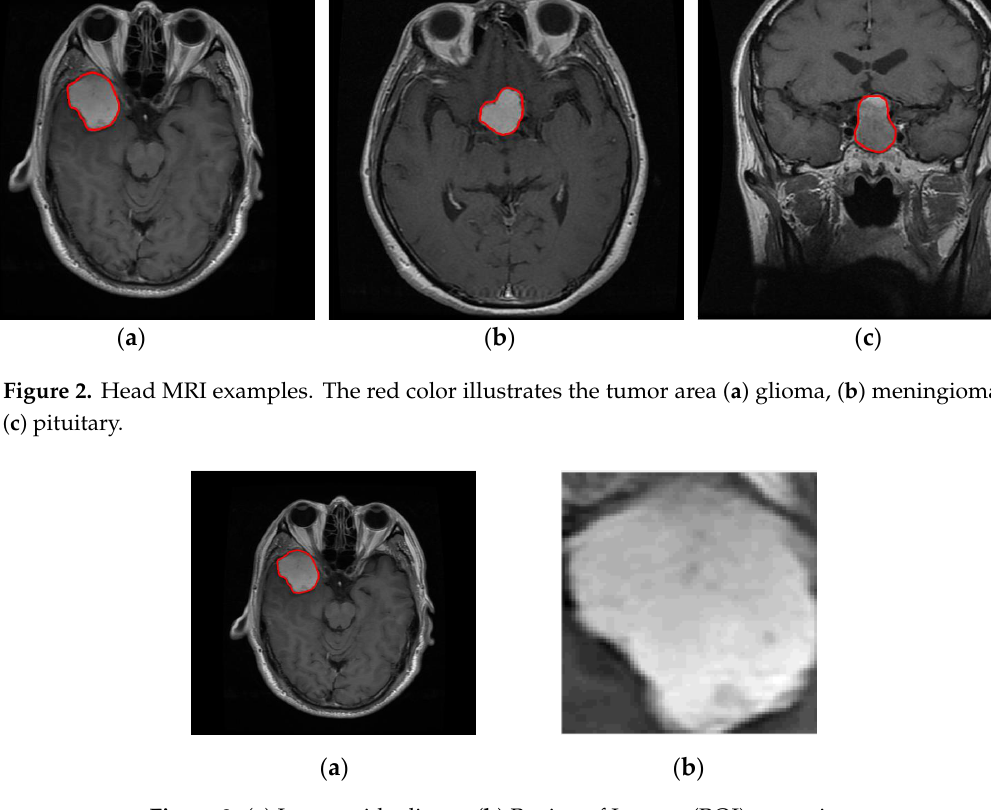
Figure 3. ( a ) Image with glioma, ( b ) Region of Interest (ROI) extraction.